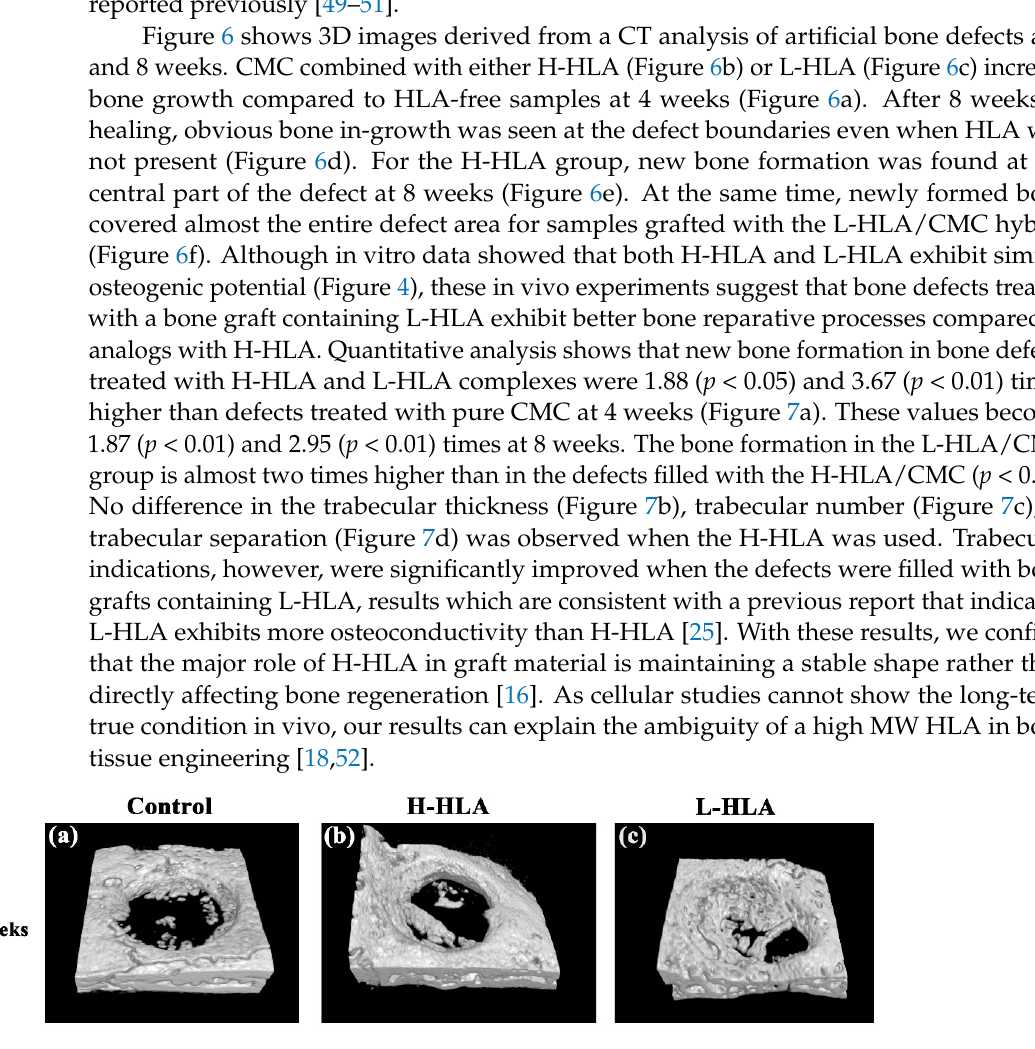
Figure 7. Micro-CT analysis of new bone formation ( a ), trabecular thickness ( b ), trabecular number ( c ), and amount of trabecular separation ( d ). Data are expressed as mean + standard deviation. Sig- nificance is indicated as * ( p < 0.05) and ** ( p < 0.01).